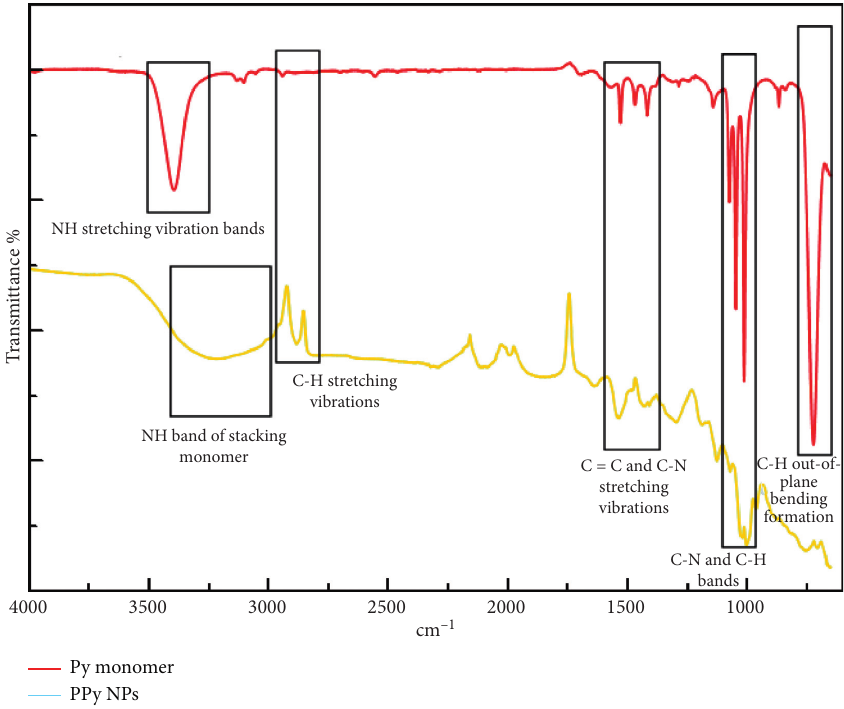
Figure 4: FTIR spectra of pyrrole monomer and PPy